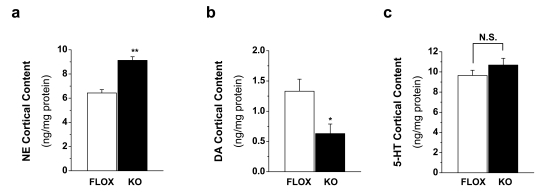
Monoamine content in the rostral cortex is significantly altered in rictor KO mice.Tissue content of (A) NE, (B) DA, and (C) serotonin (5-HT) in rostral cortical homogenates. Results are presented as mean±s.e.m ng/mg of protein, n = 4–10. *p<0.05; **p<0.01 Student's t test.